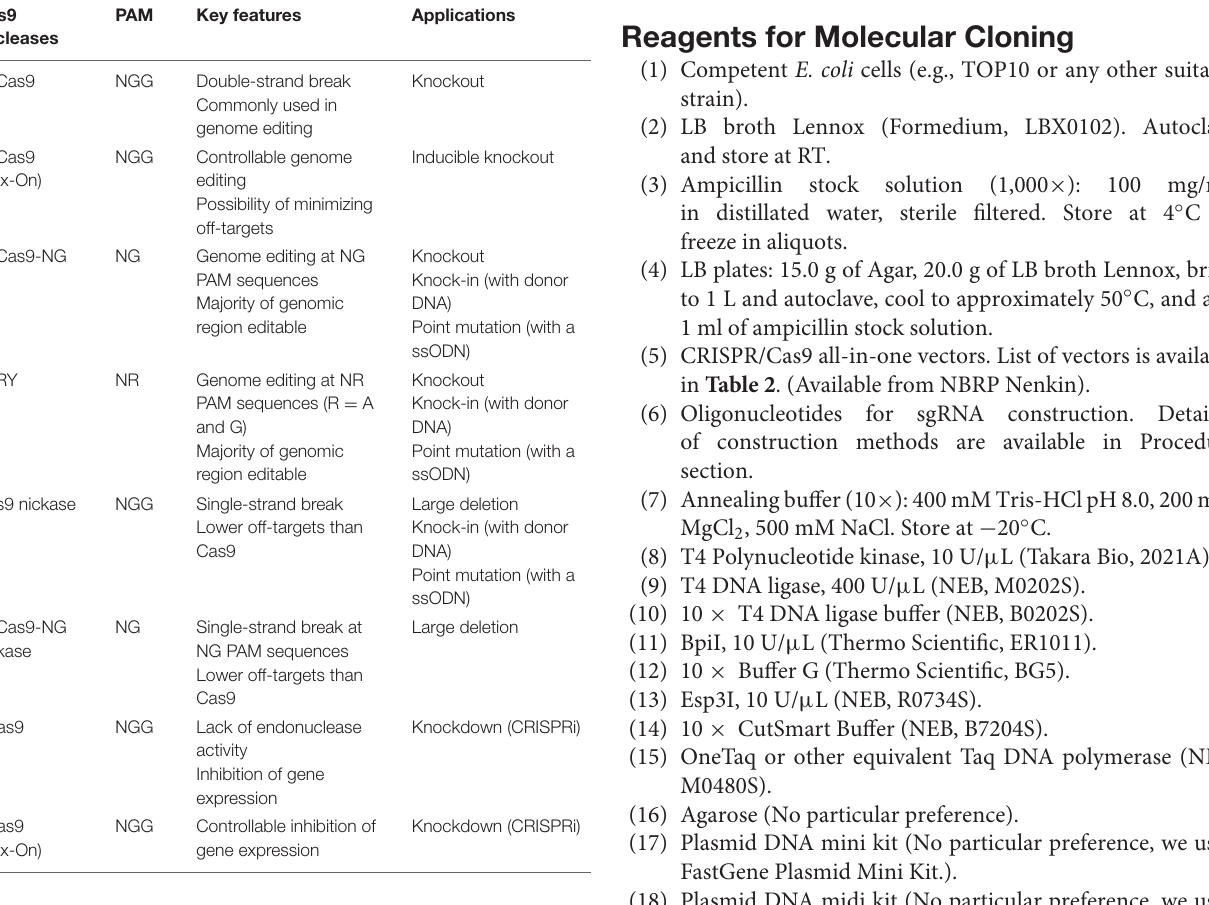
TABLE 1 | Comparison of various Cas9 nucleases and applications in genome